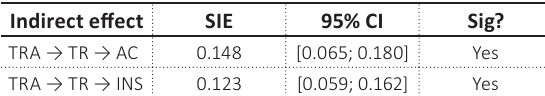
Table 8. Mediation analysis results